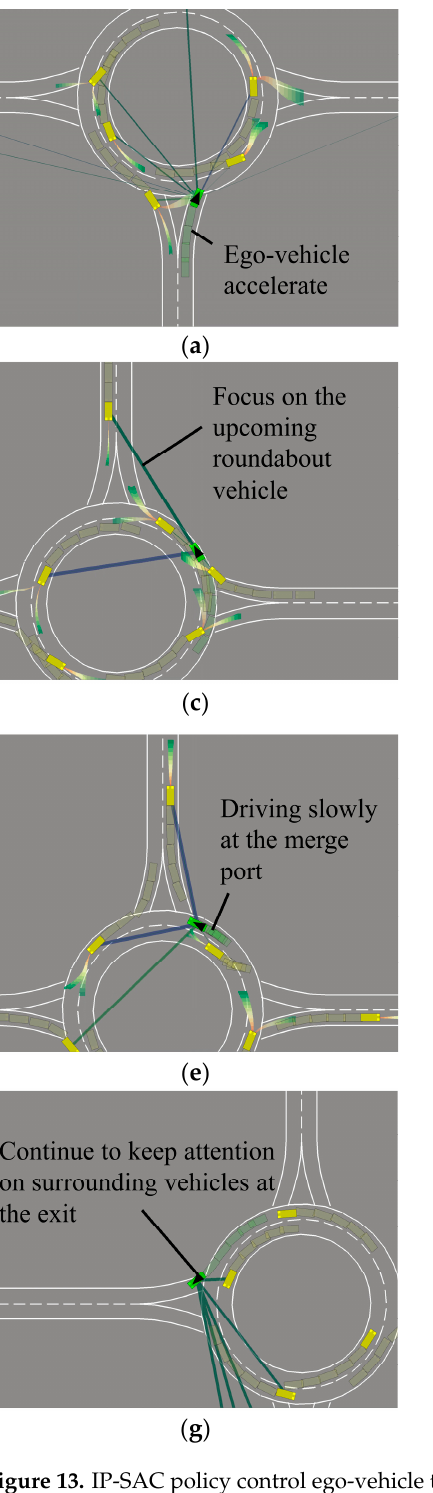
Figure 12. Comparison of SAC policy and IP-SAC policy in the case of oncoming vehicle on the right. ( a ) SAC Policy. ( b ) IP-SAC Policy.